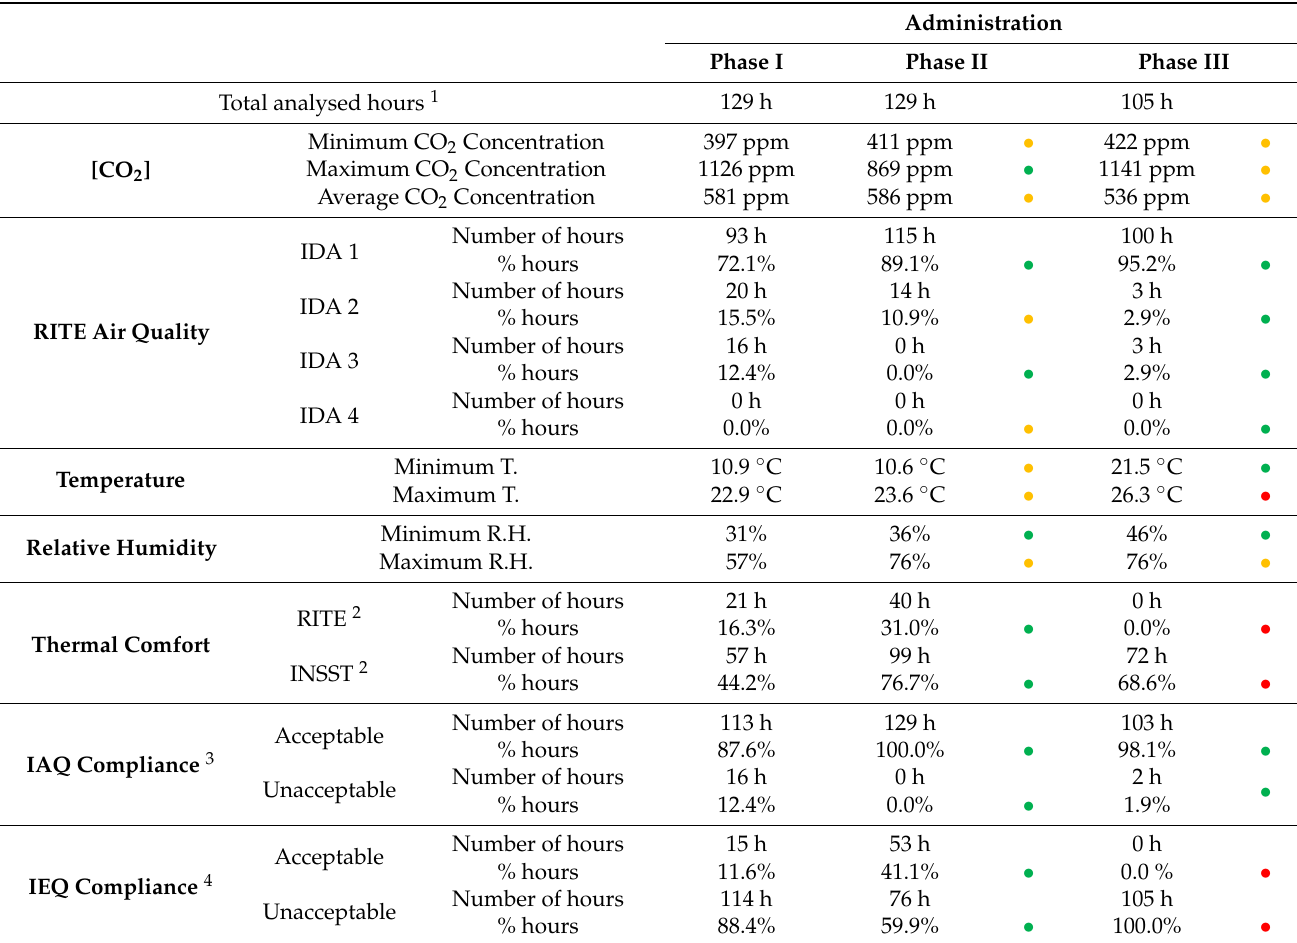
Table 5. Summary of results and phase comparison for the administration